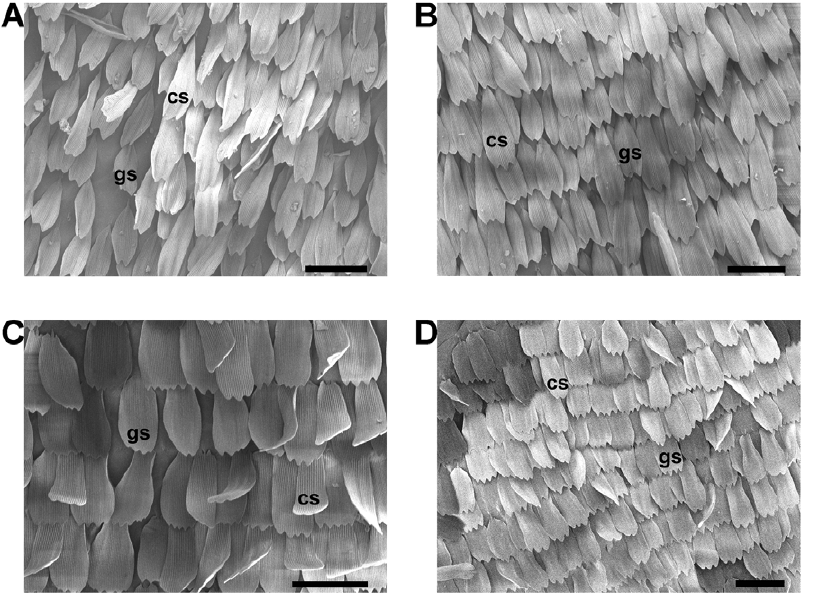
Figure 1. SEM images of a tiny section of the hind wing. Showing the arrangement of ground scales (gs) and cover scales (cs) on the wing. ( A ) The Tiger Moth ( Spilosoma niveus ). ( B ) The Clouded Buff ( Rhyparioides amurensis ). ( C ) The Indian Cabbage White Butterfly ( Pieris canidia ). ( D ) The Asian Pale Clouded Yellow ( Colias erate ). Scale bar, 100 m m.